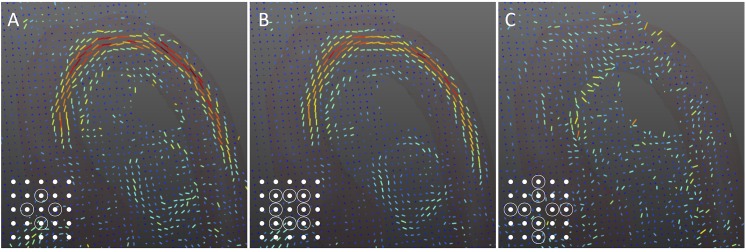
Algorithm Comparison.Vector fields resulting from three different algorithms for vorticity approximation: (A) first order central difference, (B) 8-point-circulation method, and (C) second order central difference. In the bottom left corner, the calculation scheme of each algorithm is given, illustrating adjacent data points that are taken into account for derivative calculation (schemes similar to [40]). While all three algorithms were adopted to a three-dimensional pattern for this work, 2D patterns are shown for simplicity.